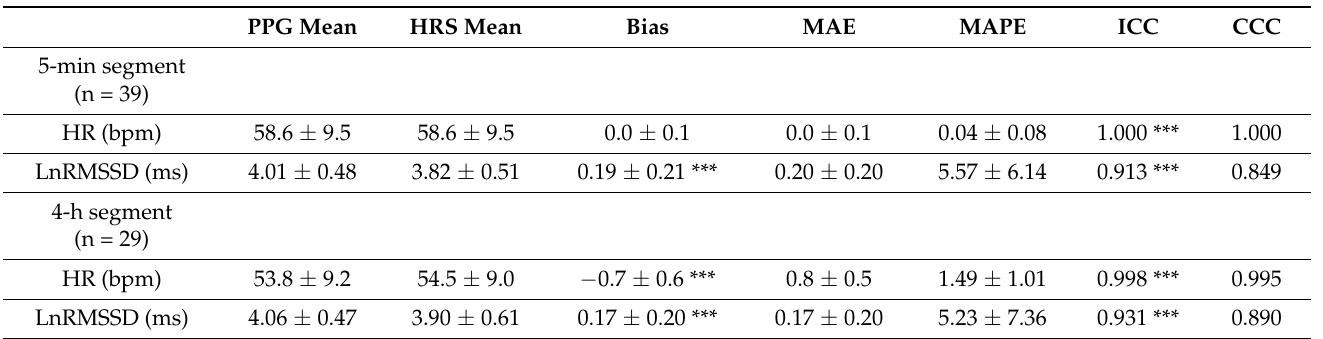
Table 2. Comparison between the mean ( ± SD) PPG and HRS in the laboratory (5-min segment) and nocturnal (4-h segment) recordings.